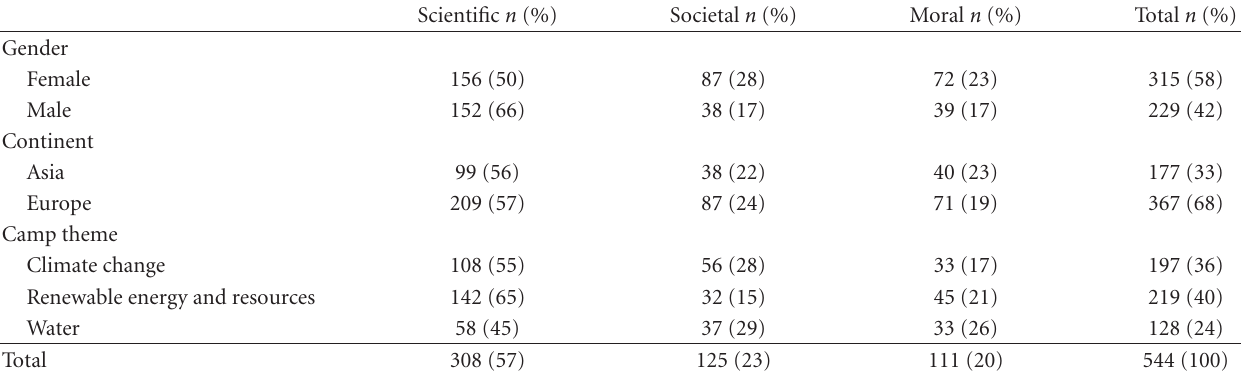
Table 1: Frequencies and percentages of scientific, societal, and moral questions by gender, continent, and camp